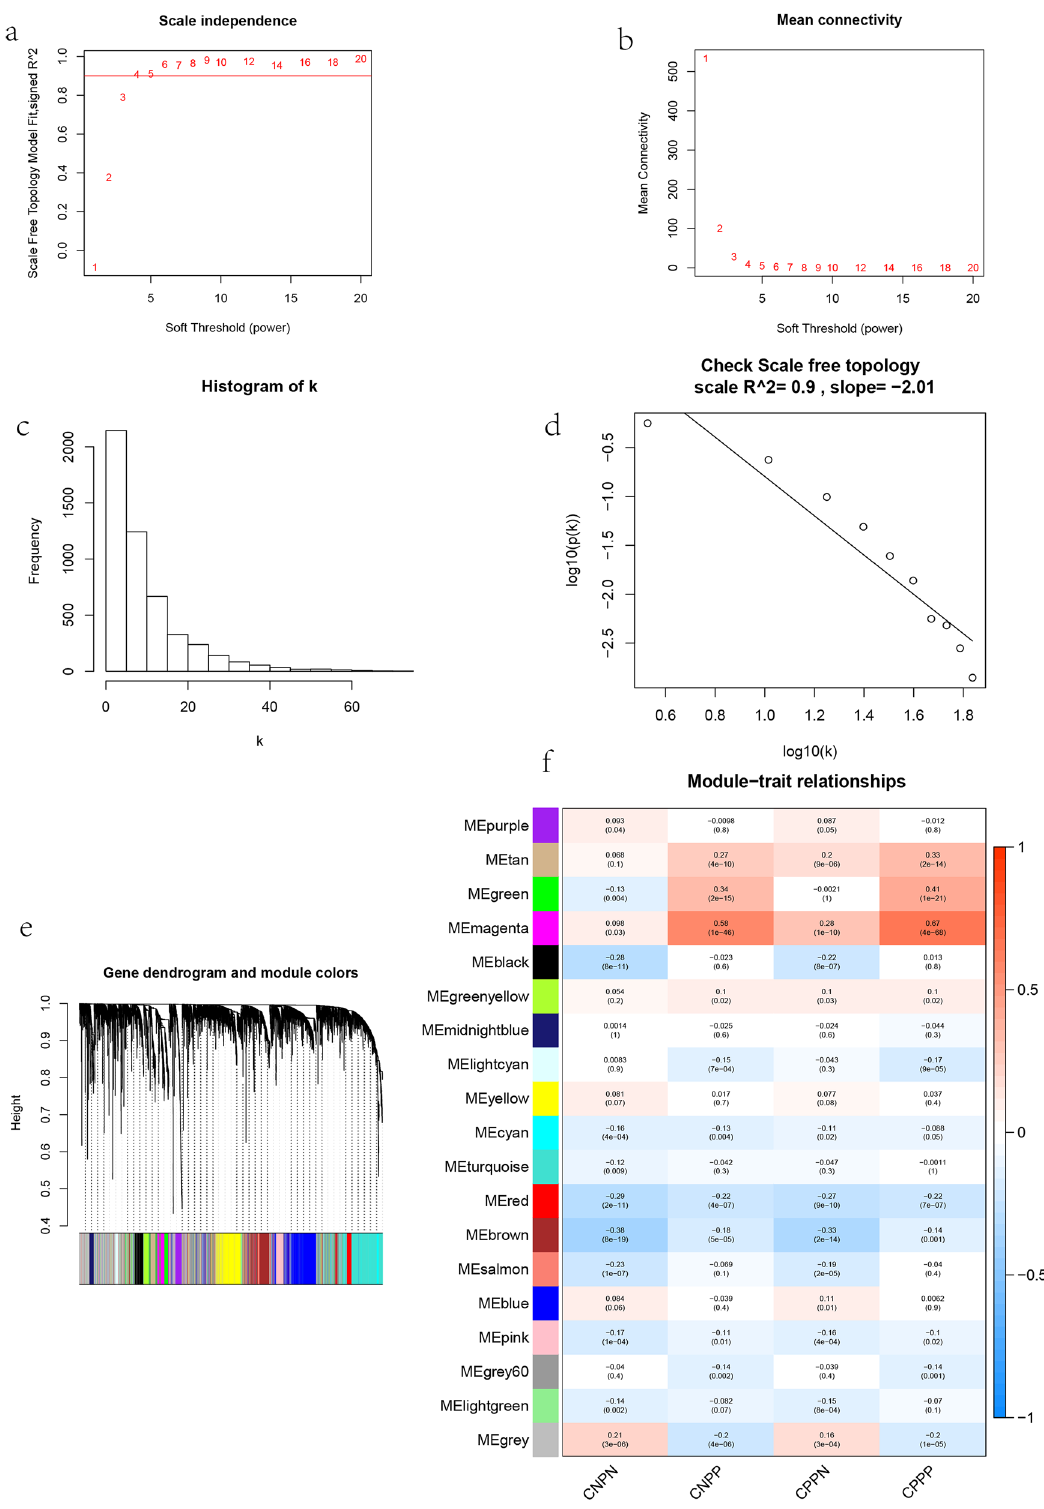
Figure 1. Sample dendrogram and soft-thresholding values estimation. ( a ) Scale free index analysis of coexpression module genes under different soft thresholds. ( b ) Average connectivity analysis of coexpression module genes under different soft thresholds. ( c , d ) β = Scale free topology at 5. ( e ) Gene clustering tree based on topological overlap. ( f ) heat map of correlation between 19 module genes and different characteristics.